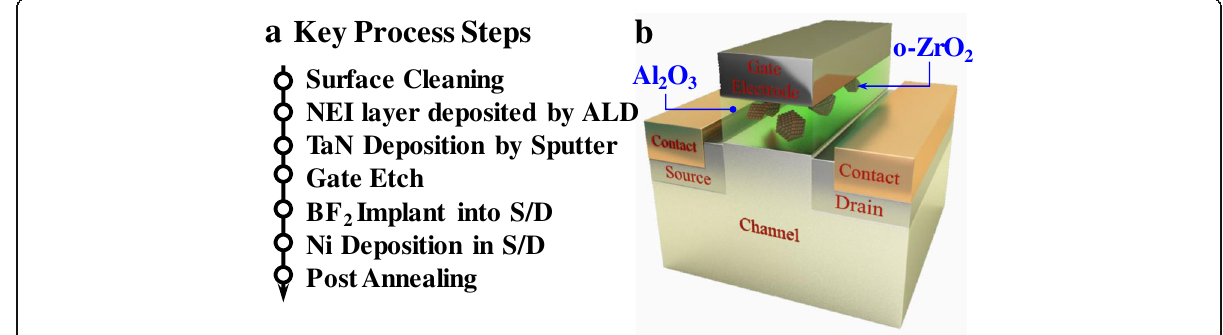
Fig. 1 a Key process steps for the fabrication of the NEI ferroelectric field-effect transistors. b 3D schematic of the fabricated NEI FeFET